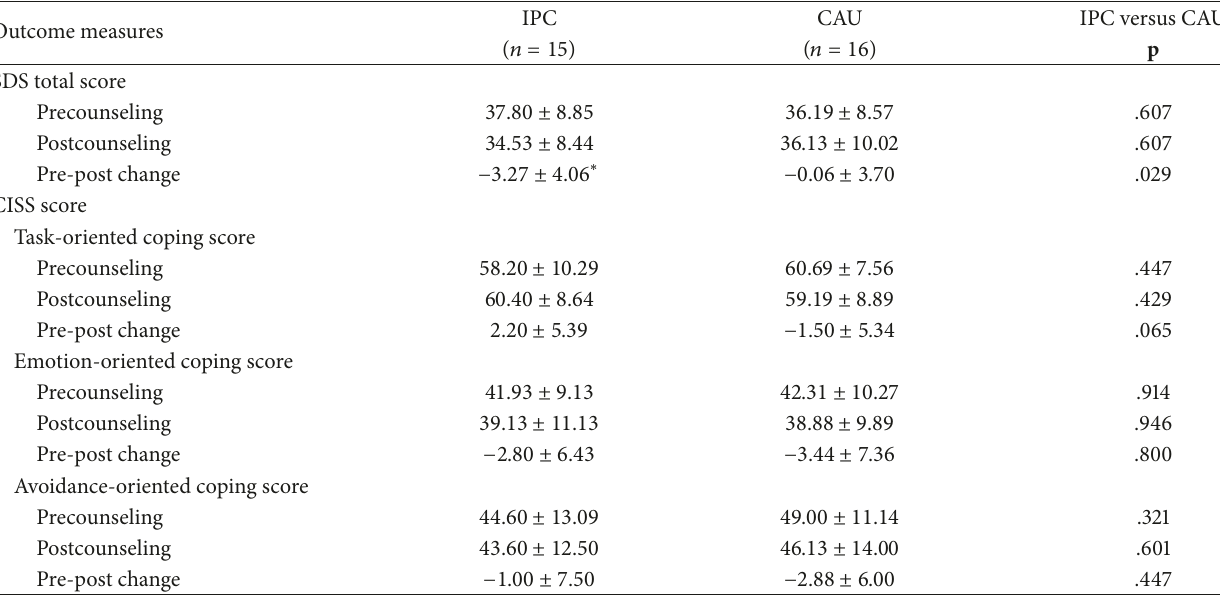
Table 2: Outcomes by counseling